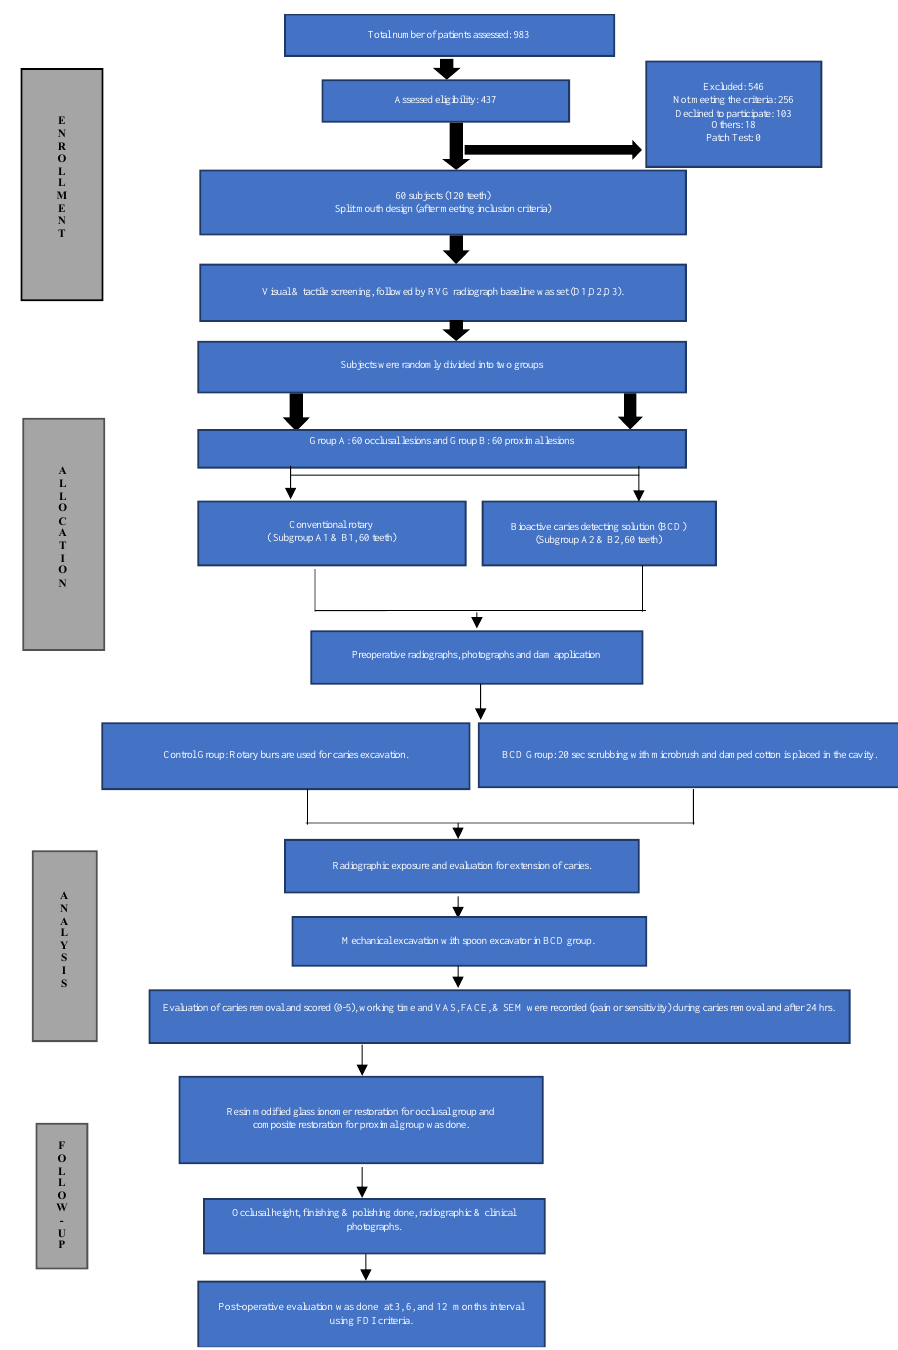
Figure 1. Flow chart of clinical study (CONSORT) for BCD.